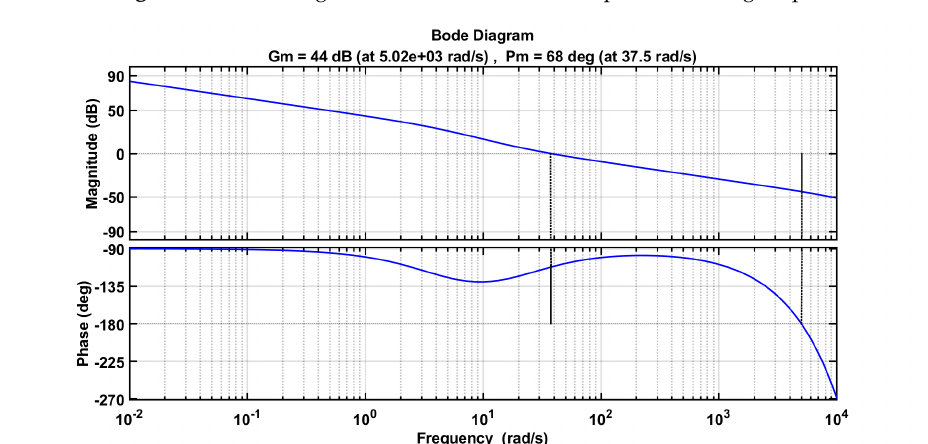
Figure A1. Bode diagram for transfer function of power tracking loop.